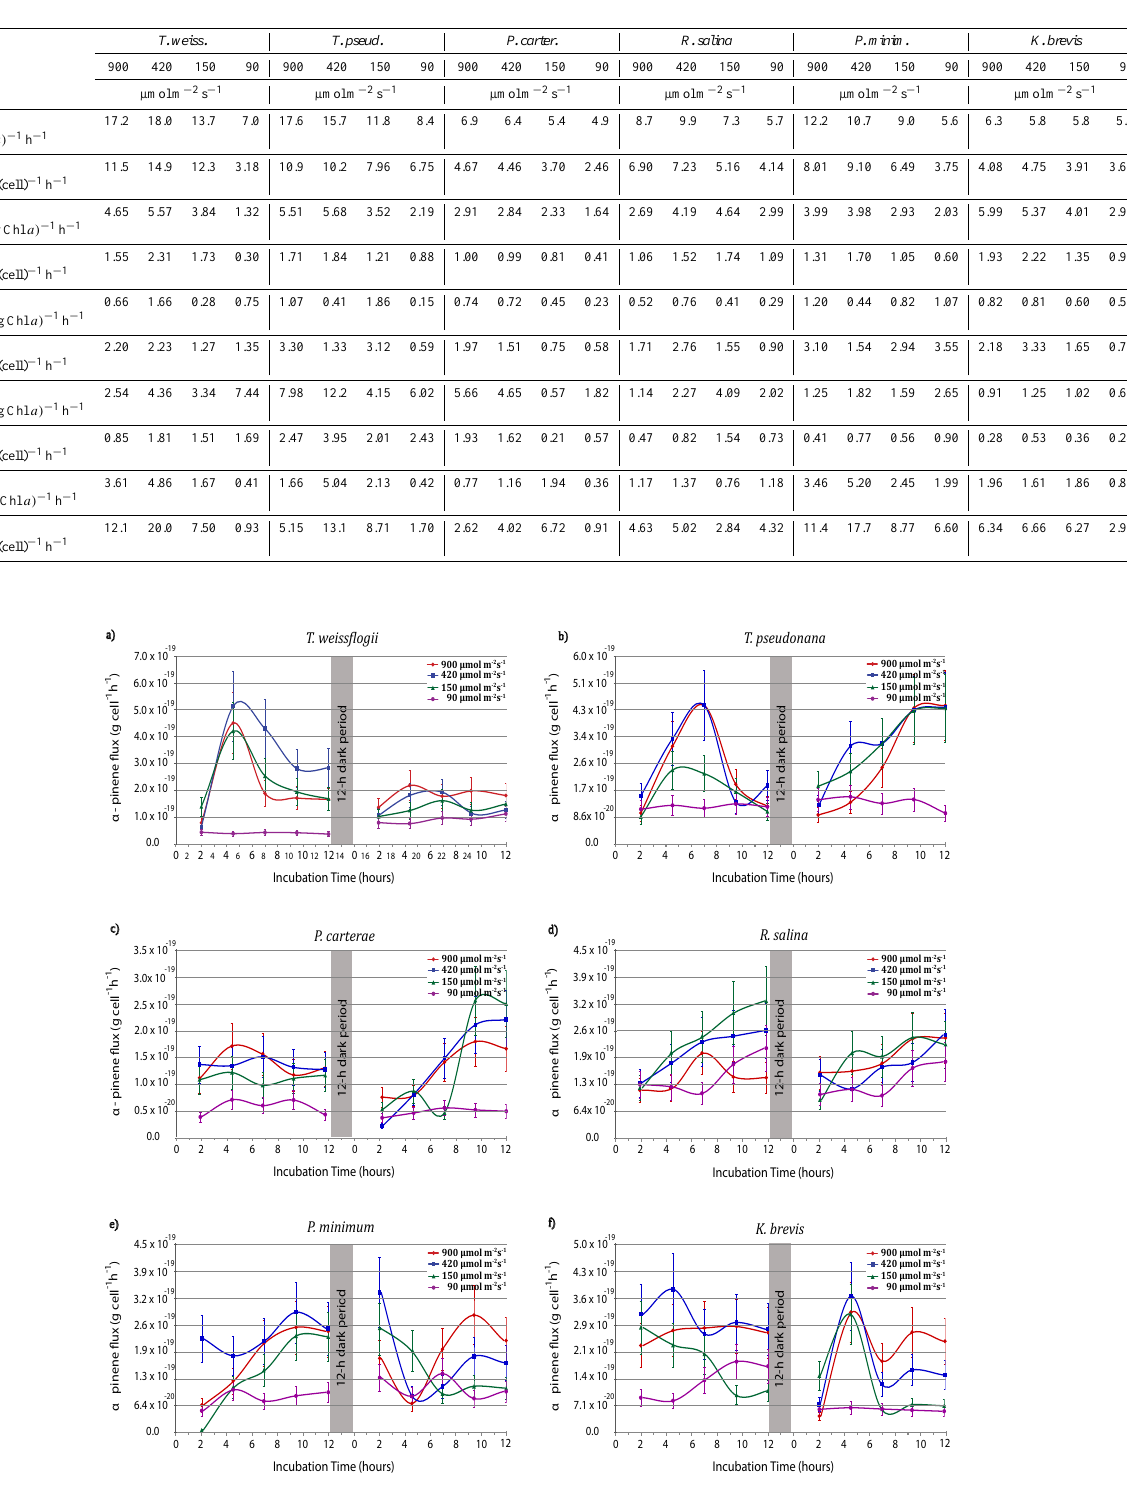
Table 2. Isoprene and monoterpene production rates from phytoplankton monocultures averaged over a 12h period on the first day.